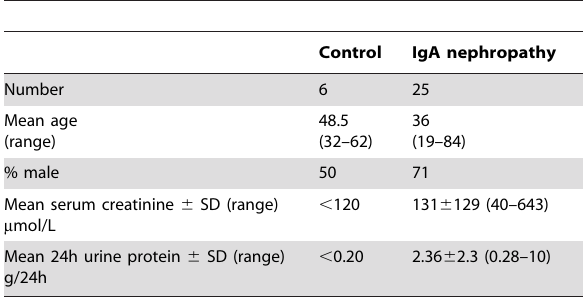
Table 2. Patient characteristics – subjects with IgA